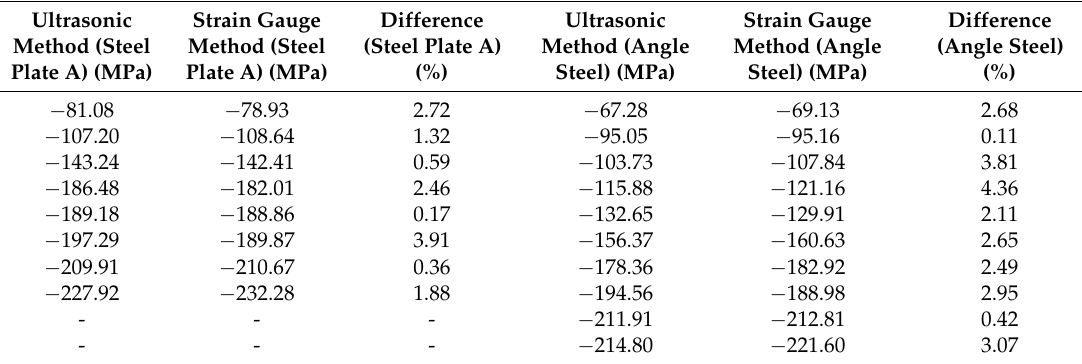
Table 3. Comparison between two methods of steel plate A and angle steel.